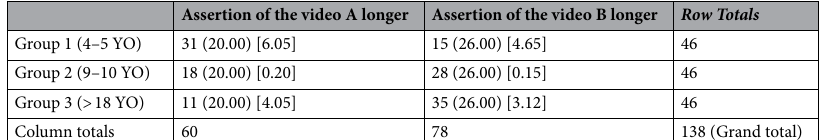
Assertion of the video A longer Assertion of the video B longer Row Totals